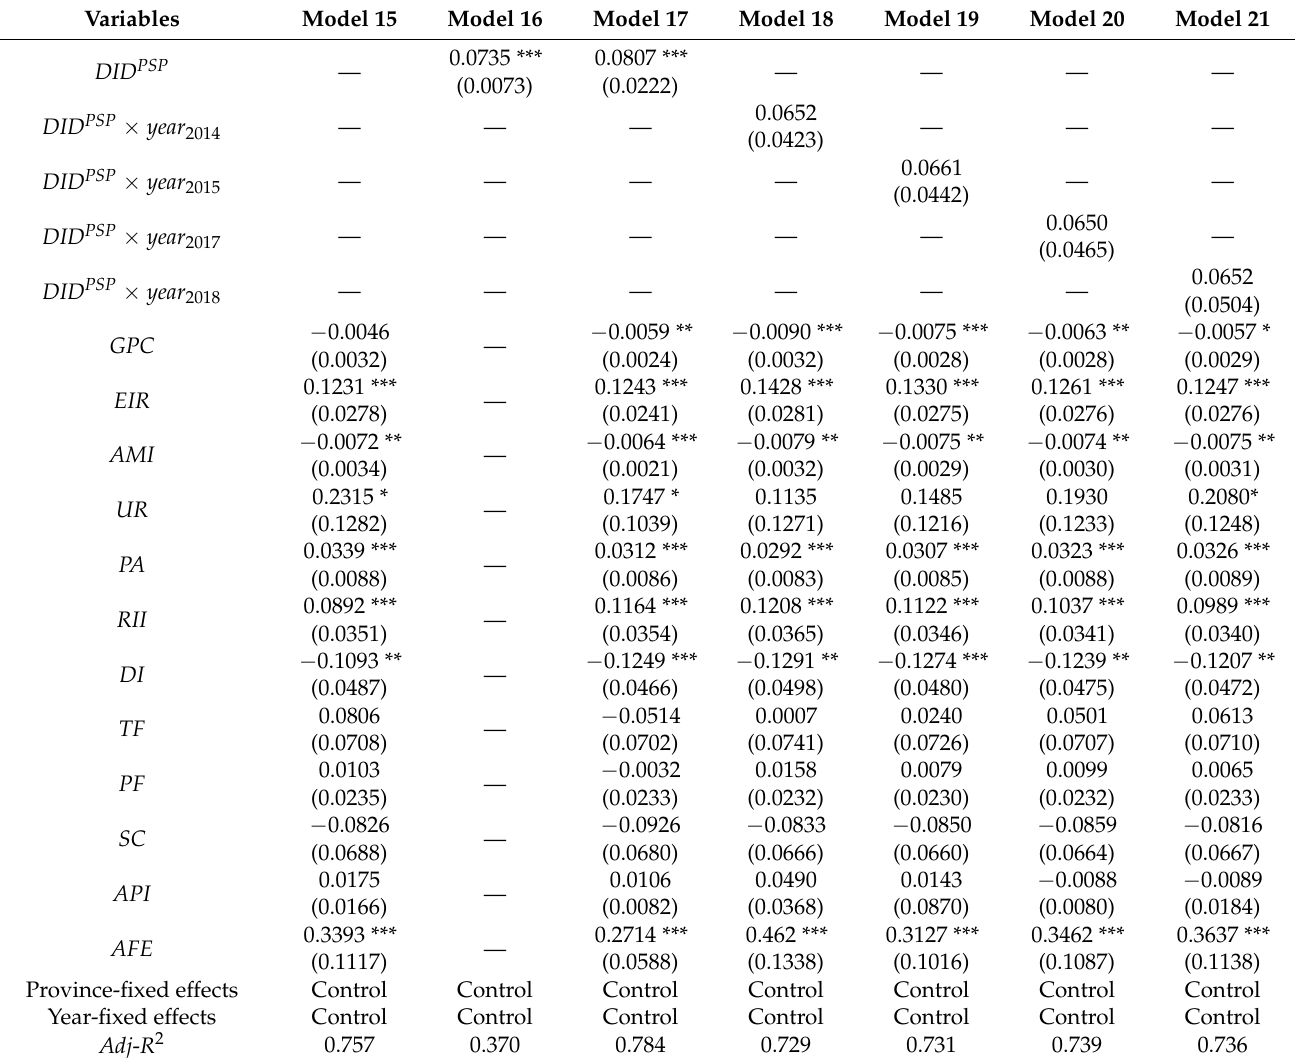
Table 6. DID analysis results of the